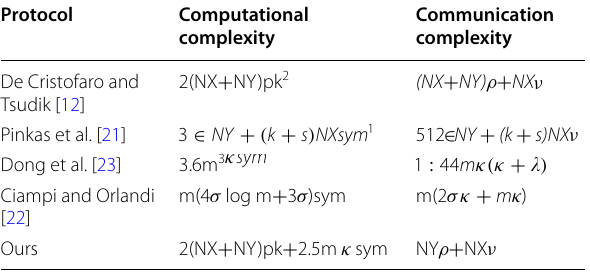
1 k,s: The parameters used in the hash function. 2